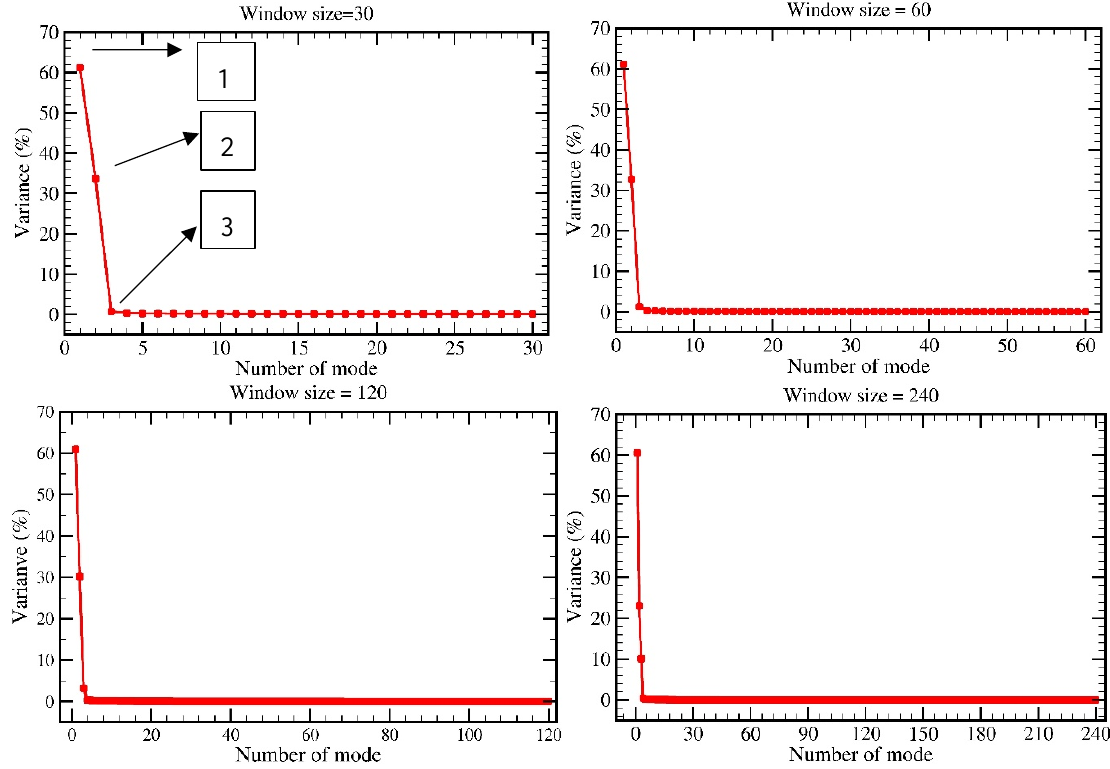
Figure 8. Graph of normalized singular values with image window sizes of 30, 60, 120, and 240.